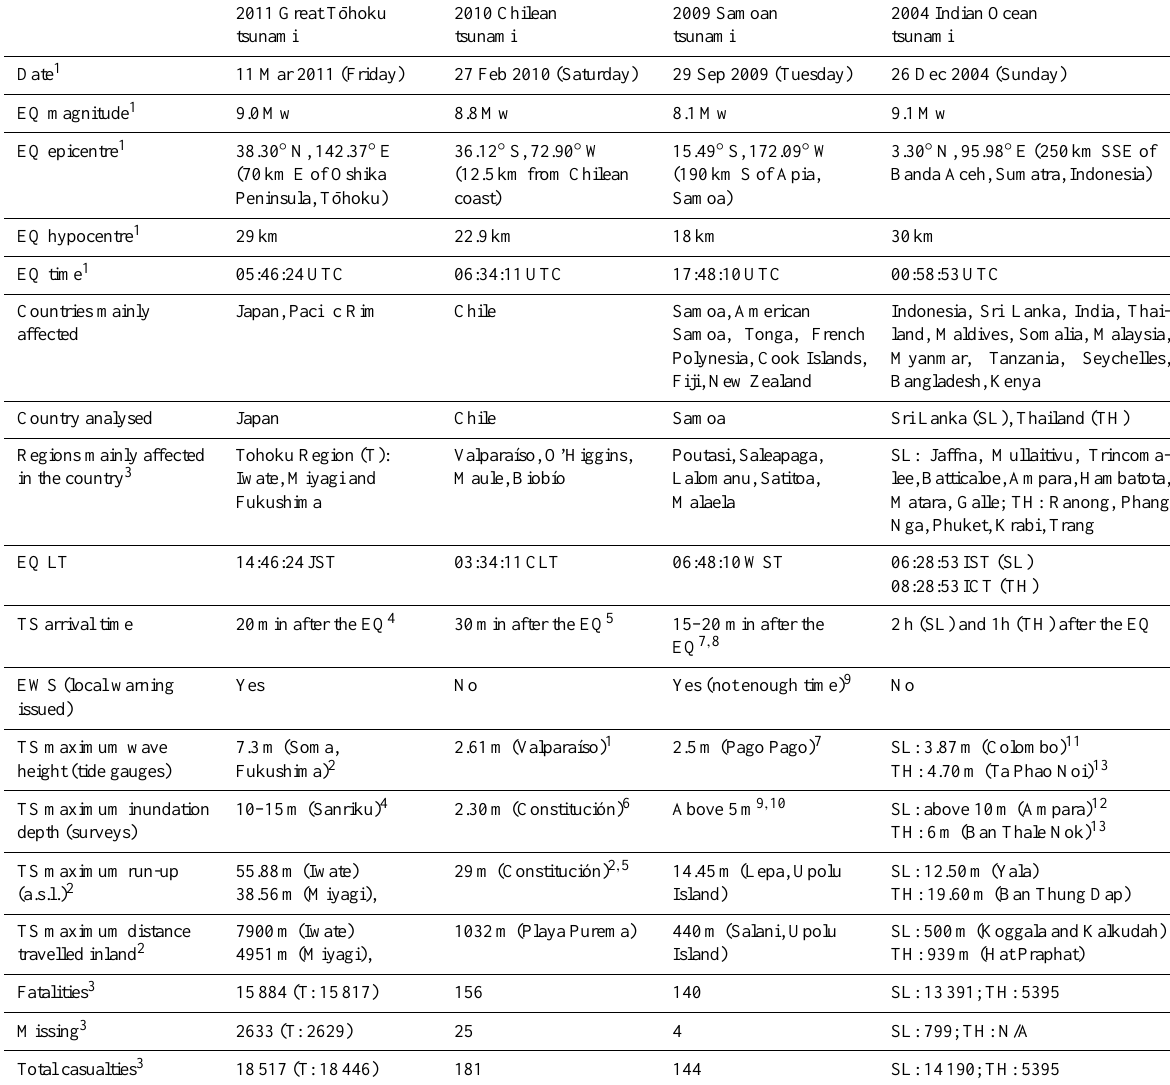
Table 2. Description of the past tsunami events used to validate the human vulnerability